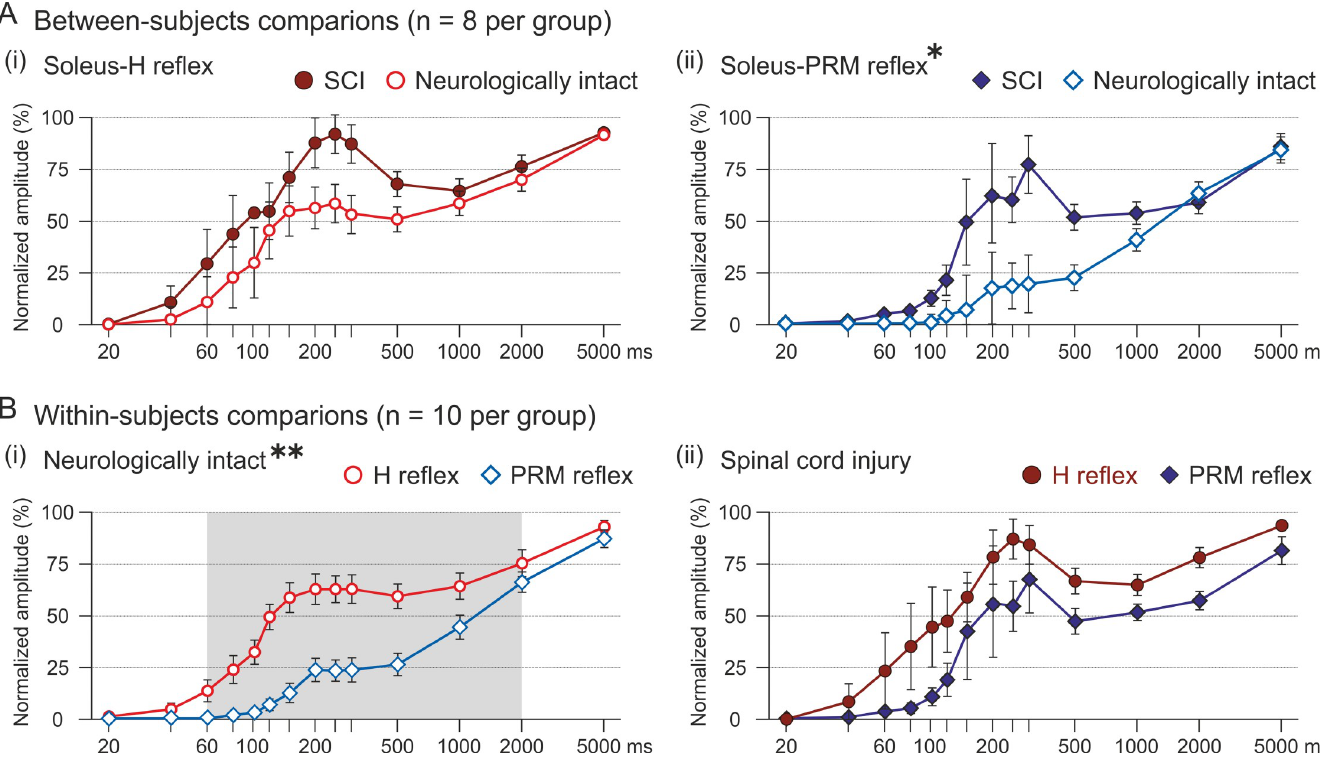
Fig 2. Recovery cycles of H reflexes and PRM reflexes of soleus in neurologically intact individuals and individuals with spinal cord injury. (A) Between-subjects comparison (n = 8 each) of the recovery cycles of (i) the H reflex and (ii) the PRM reflex of the right soleus with increasing conditioning-test intervals (x-axis, logarithmic scale). The y-values are group means ± SE of the normalized peak-to-peak amplitudes (second to first response) per conditioning-test interval. For the PRM reflex recovery cycle, there was a significant main effect of neurological status ( � , P < .05). (B) Within-subjects comparison of recovery cycles of H reflexes and PRM reflexes (n = 10 each) in (i) neurologically intact individuals and (ii) individuals with spinal cord injury. In the neurologically intact individuals, there was a significant main effect of reflex type ( �� , P < .01) as well as a significant interaction between reflex type and conditioning-test interval. Shaded background marks all conditioning- test intervals with significant differences in response recovery (Bonferroni-adjusted post-hoc tests; all P <